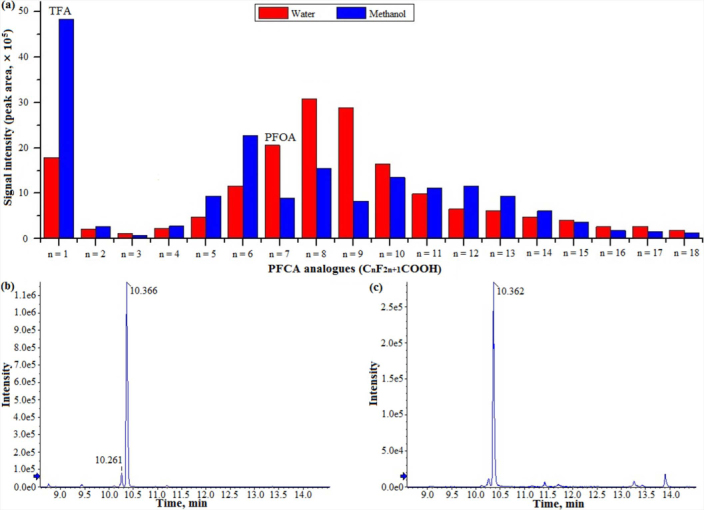
LC/ESI-MS/MS analysis of the PFCA analogues (CnF2n+1COOH, n = 1-18) in NaOH and methanol absorption solutions (a), and extracted ion chromatograms (EIC) corresponding to the deprotonated molecular ion [M-H]− of PFOA (m/z 412.97) in NaOH (b) and methanol (c) absorption solutions.